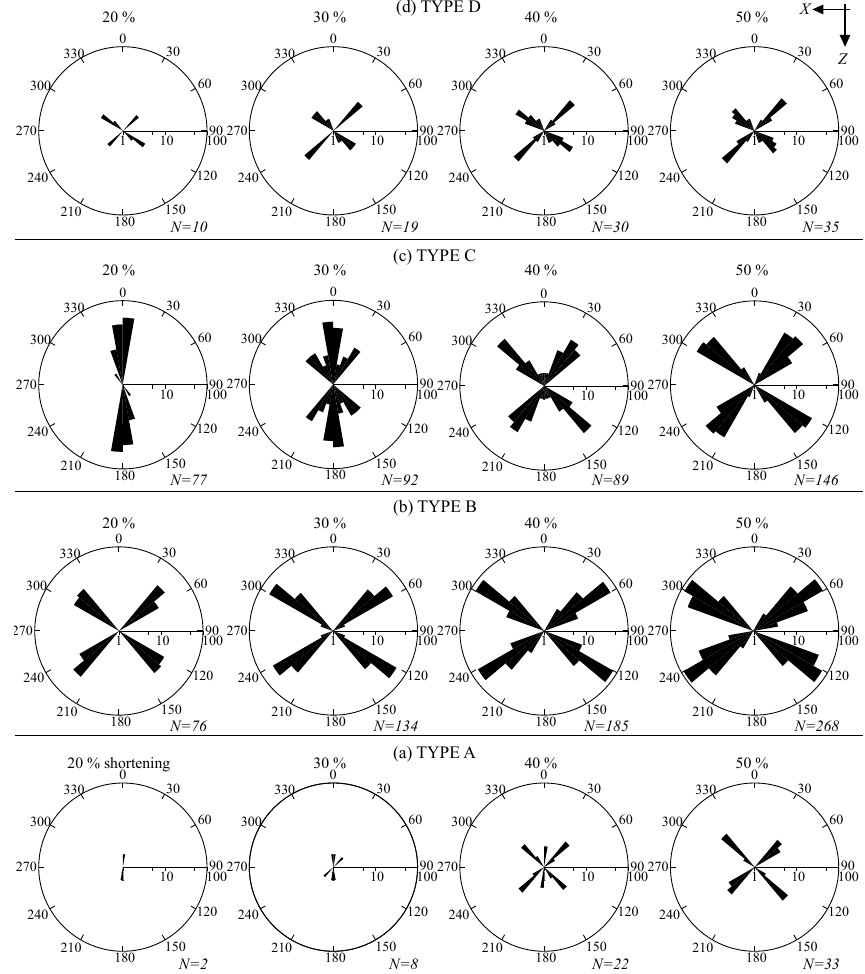
Figure 7. Rose diagrams showing the orientation and number of fractures (at orientation intervals of 10 ◦ ) of experiments: (a) type A, (b) type B, (c) type C and (d) type D. N is the number of data measurements in each diagram. Only fractures measured within the sampling area are included. Note that horizontal scales are